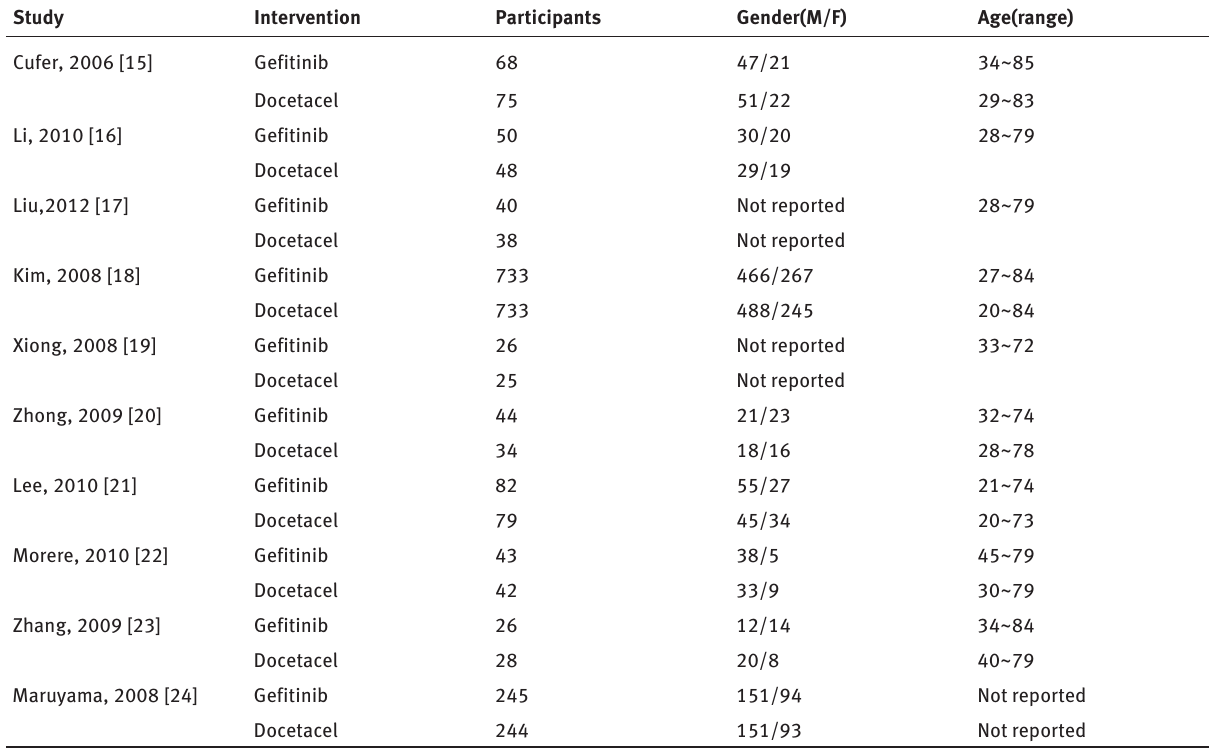
Table 1: Baseline characeristics of included studies Study